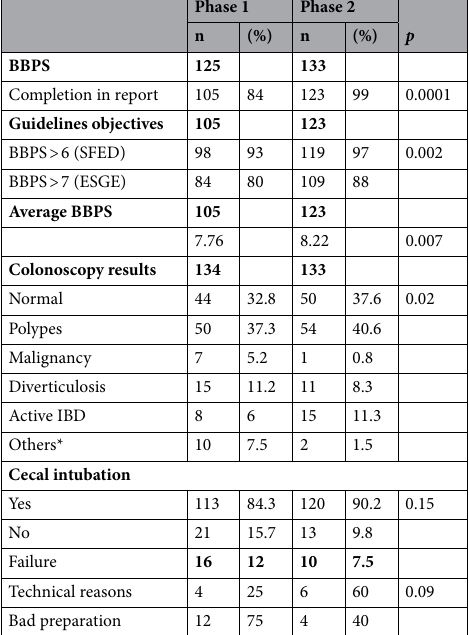
Table 3. BBPS and colonoscopy results. BBPS: boston bowel preparation scale, SFED: French society of digestive endoscopy, ESGE: European society of gastrointestinal endoscopy, IBD: inflammatory bowel disease. *2 angiodysplasia, 2 infectious colitis, 2 post-radiation colitis, 1 ischemic colitis and 3 unclassified colitis. Significant values are in bold.